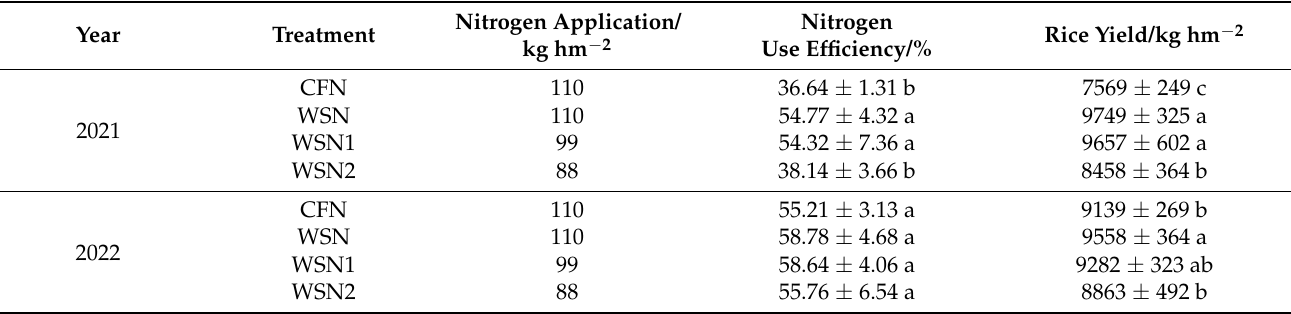
Table 4. Rice yields and the nitrogen use